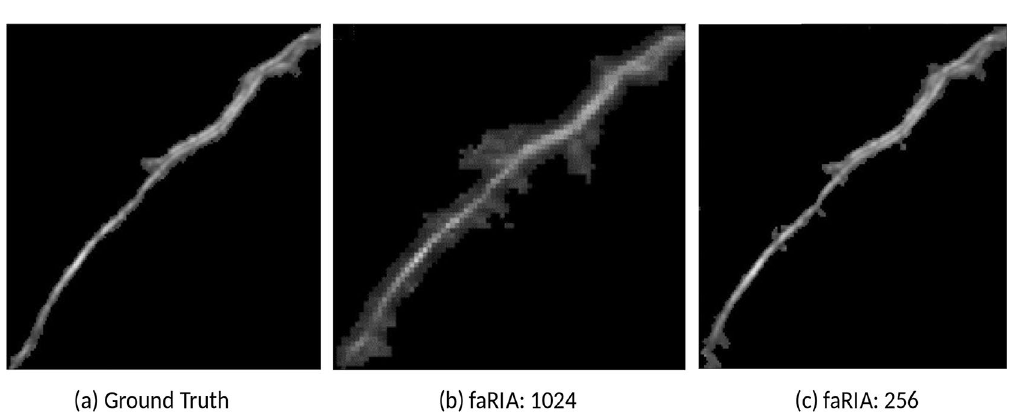
Figure 6. Segmentation artefacts: ( a ) original root structure, ( b ) faRIA:1024: noisy segmentation of ( a ) at root edges, ( c ) faRIA:256: noise-free segmentation of ( a